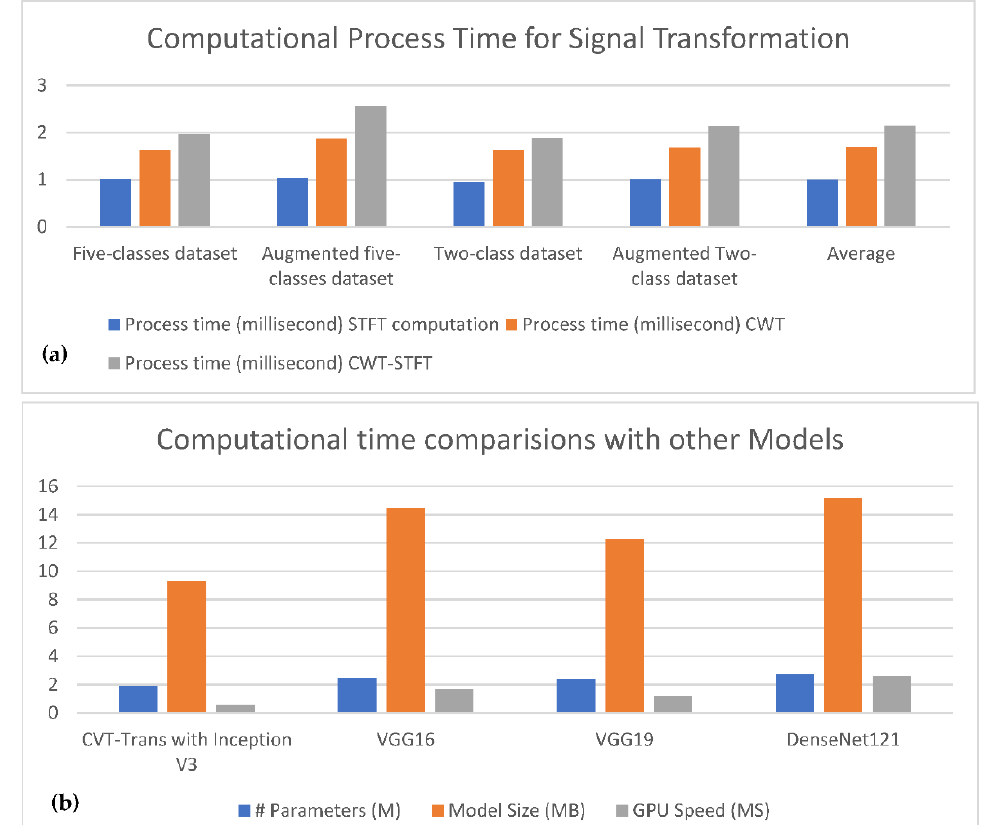
Figure 5. Computational comparisons with other transfer learning models. ( a ) The 1-D signal transferred into 2D CVT-STFT, ( b ) Classification computational cost.